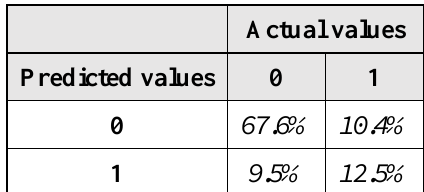
Table 5. DNN confusion